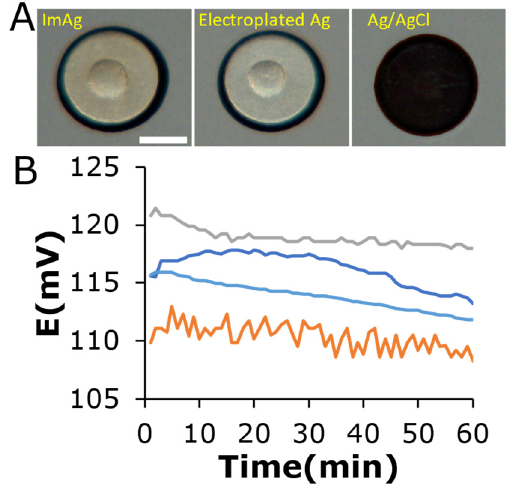
Figure 3. ( A ) Electroplated Ag/AgCl reference electrode. Photographs (left to right) of the original immersion silver layer of PCB, electroplated silver, and finished Ag/AgCl electrode after chloridiza- tion. Scale bar = 0.5 mm. ( B ) Potentiometric response of Ag/AgCl reference electrodes (n = 4) against commercial silver chloride electrode (Ag/AgCl 3 M NaCl). Electrolyte: 1 mM KNO 3 + 10 mM